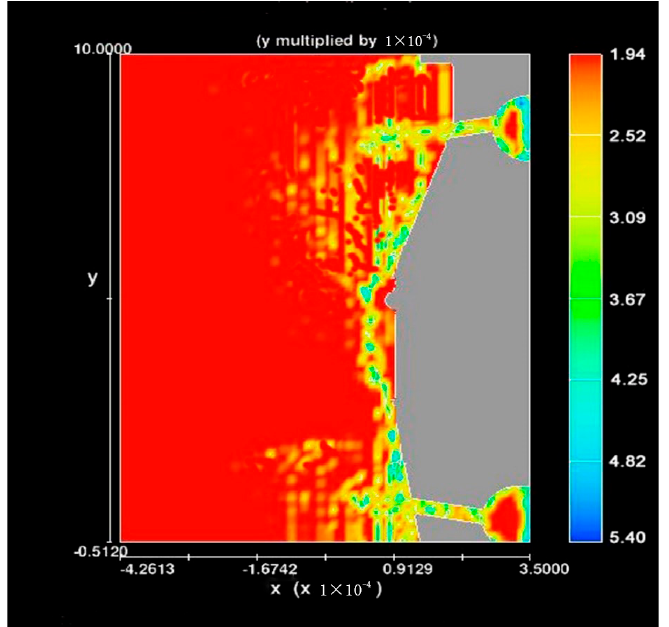
Figure 22. Offshore deposit of sediments. The right hand scale represents sediment density in slugs/ft 3 as described in the text; ocean water has the 1.94 slug/ft 3 scale representation. Intermediate scale values represent the mixing of flood derived slurry with the ocean current.